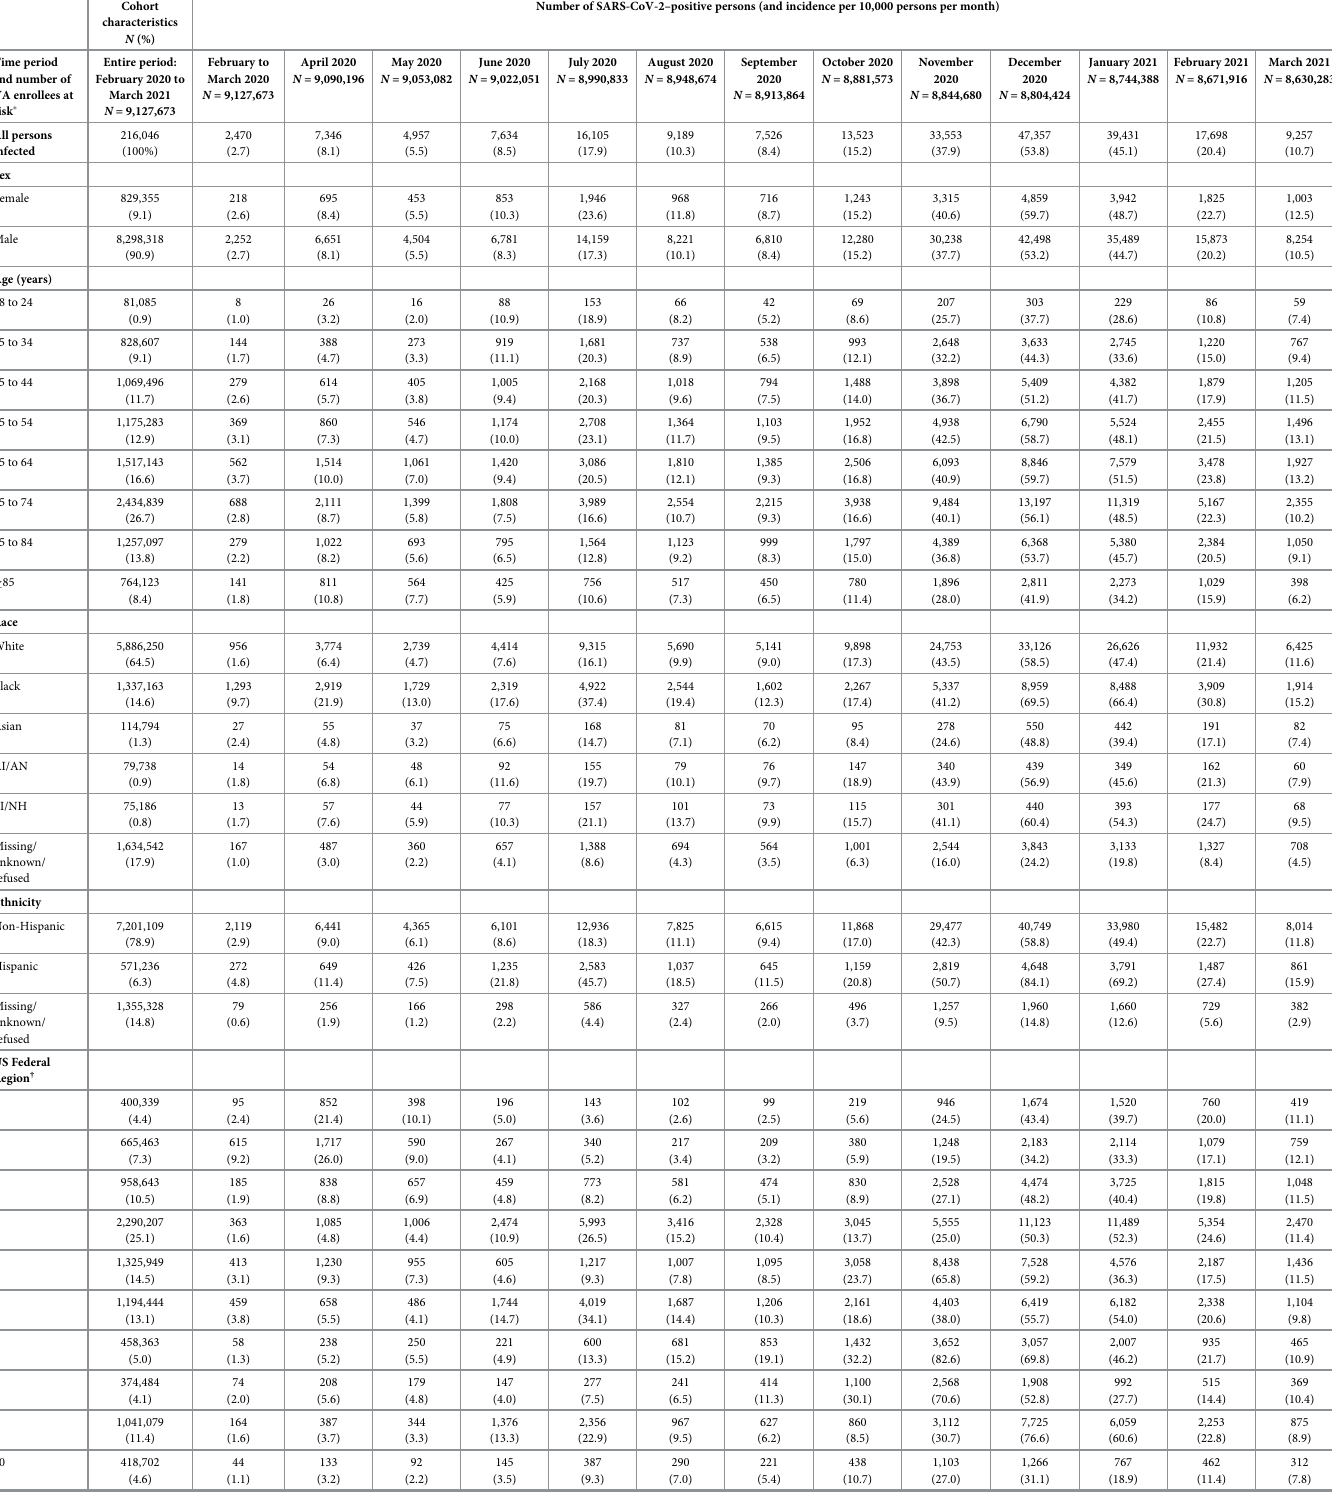
Table 1. Cohort characteristics and incidence of SARS-CoV-2 infection presented by month in a cohort of 9.1 million VA enrollees followed from February 2020 to March 2021. Cohort